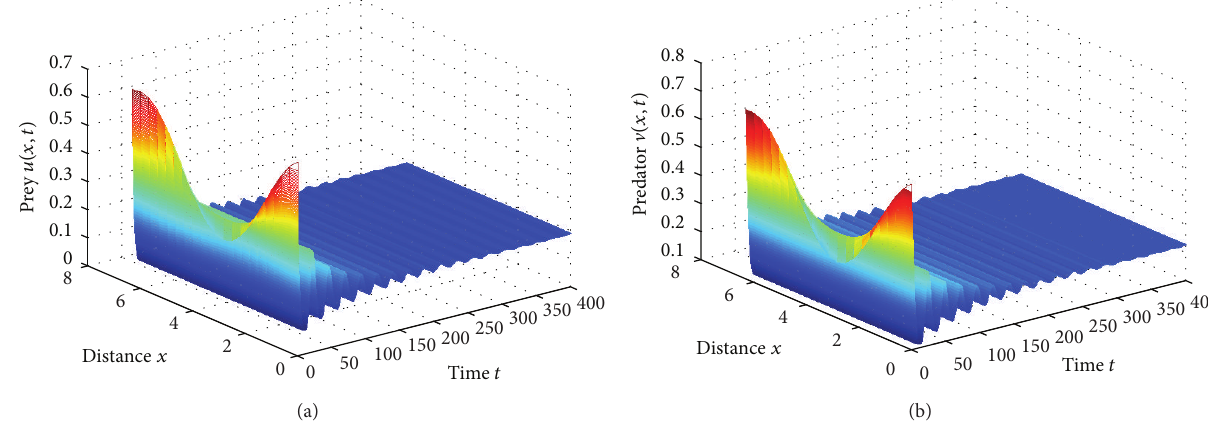
Figure 1: 𝐸(0.1892, 0.227) is asymptotically stable when 𝜆 = 0.32 > 𝜆 𝐻 0 and the initial function 𝑢 0 (𝑥) = 0.5+0.2 cos 𝑥 , V 0 (𝑥) = 0.5+0.2 cos 𝑥 .